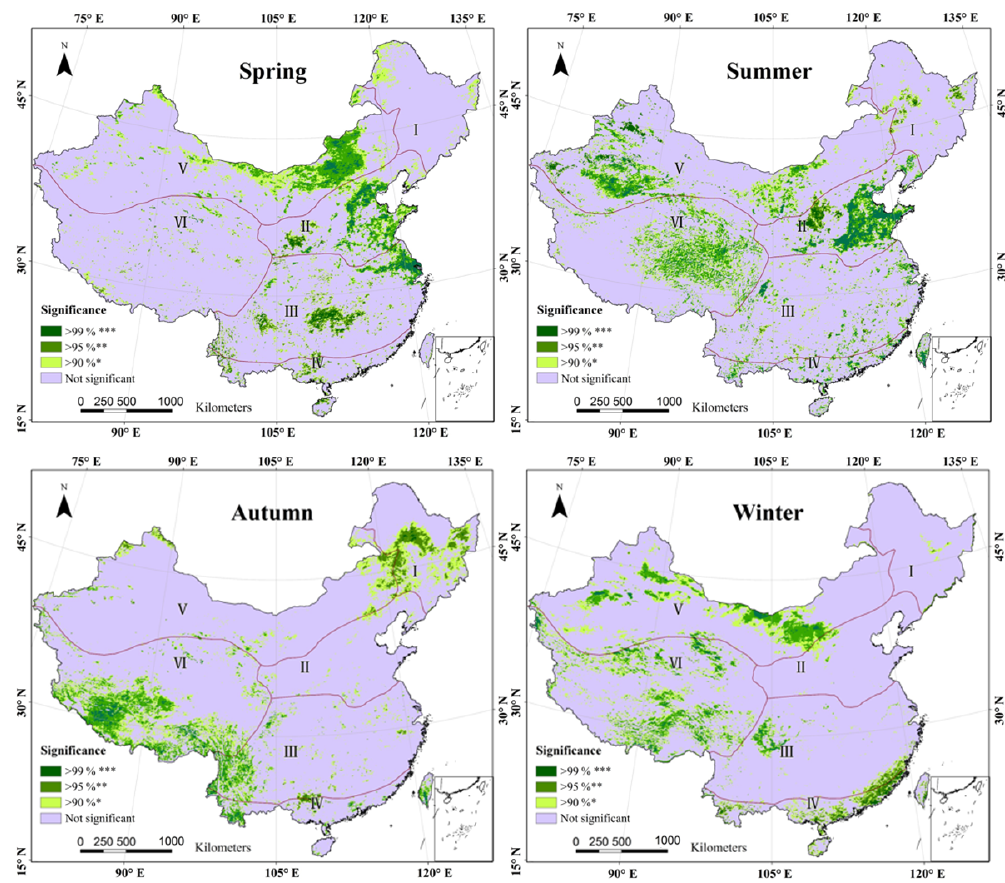
Figure B2. Distribution of seasonal LST trend significance during